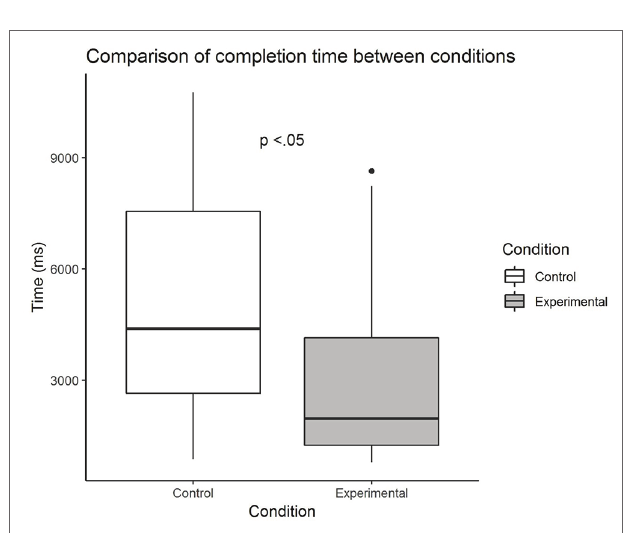
FIGURE 2 | Comparison of mean time spent on each trial between control and experimental